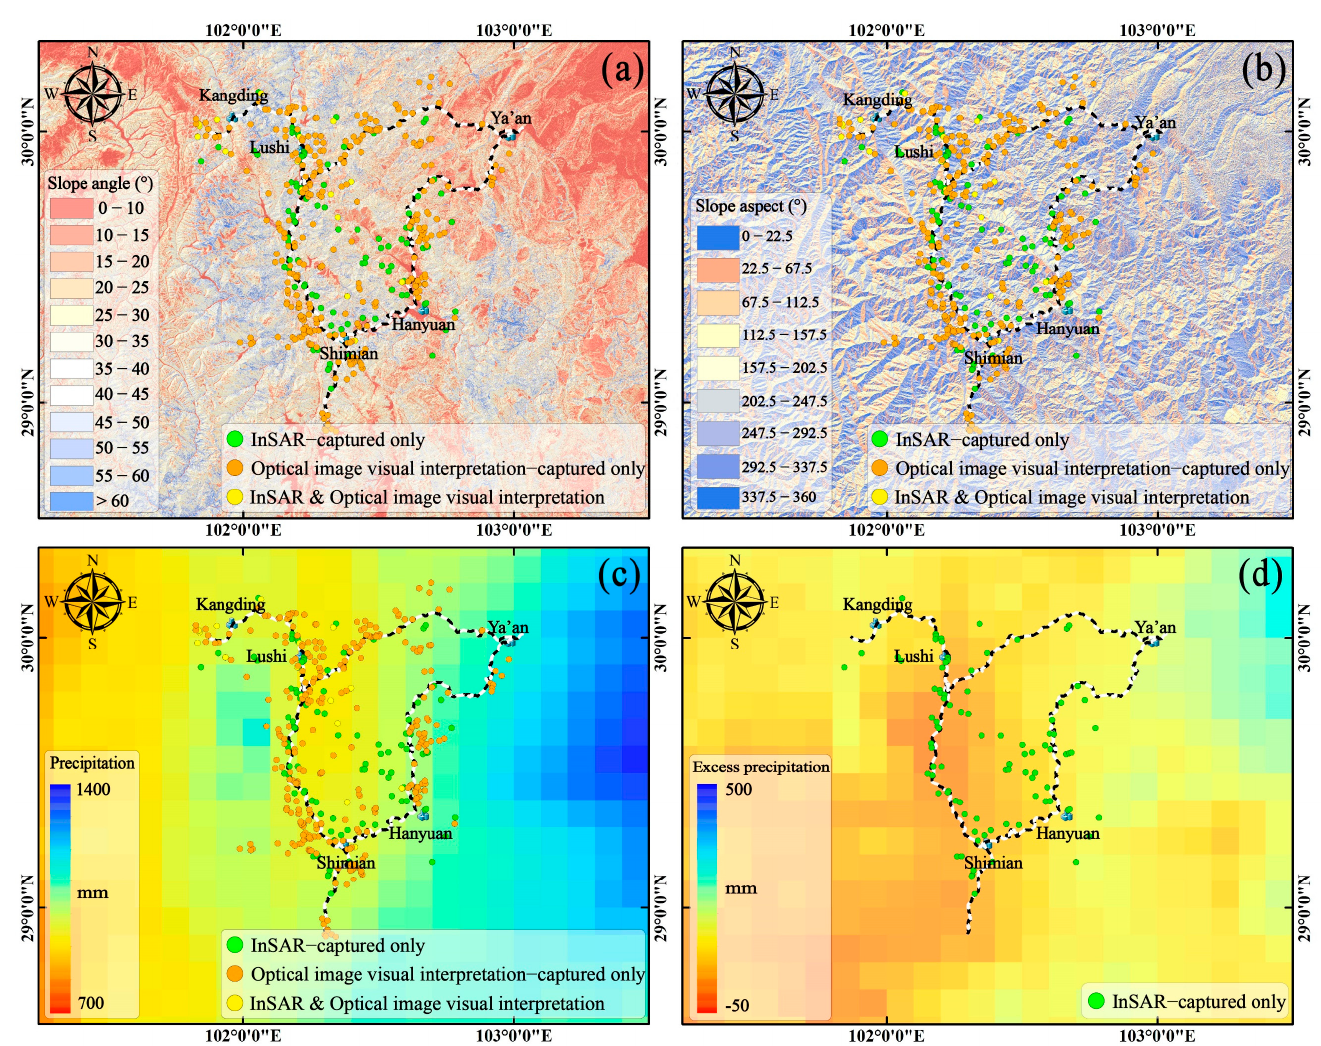
Figure 12. Spatial relationships between landslide distribution and slope angle, slope aspect, precipitation and excess precipitation: ( a ) spatial relationship between slope angle and detected landslides; ( b ) spatial relationship between slope aspect and detected landslides; ( c ) spatial relationship between precipitation and detected landslides, and ( d ) spatial relationship between excess precipitation and detected landslides.